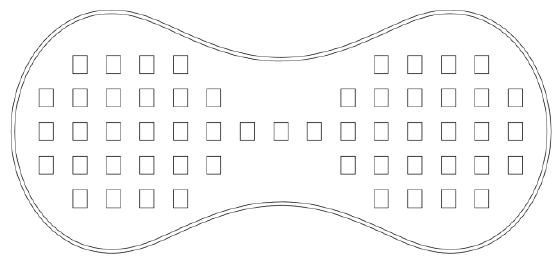
Figure 2. Schematic diagram of the LED array.